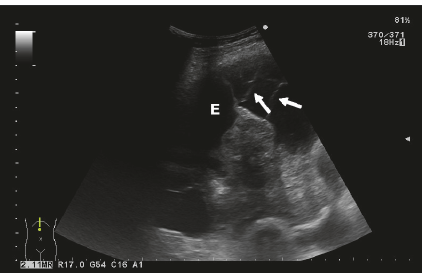
Figure 1: Typical ultrasonographic image of malignant pleural effusion with fibrinous septation. Fibrin strands within a pleural effusion can be seen (white arrows); E = pleural effusion.